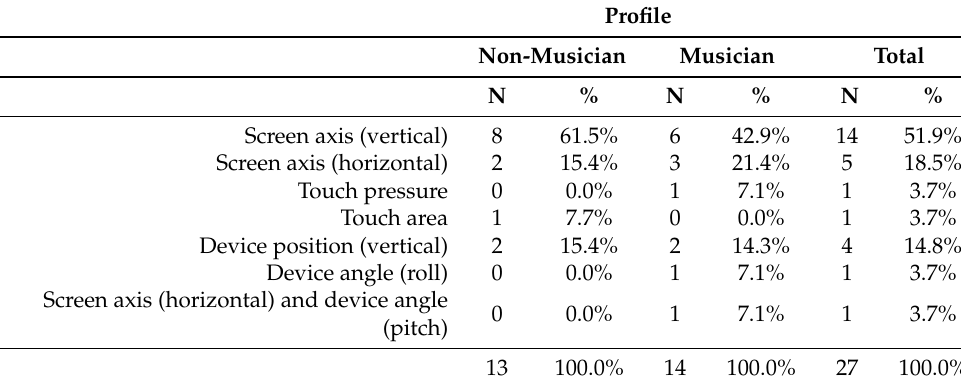
Table A6. Pitch variation mapping (uncategorized)—stimulus d.